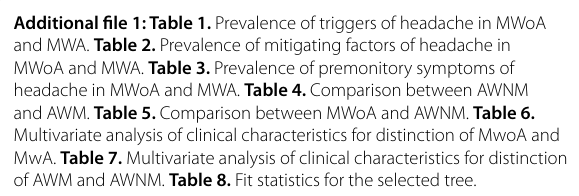
MwA. Table 7. Multivariate analysis of clinical characteristics for distinction of AWM and AWNM. Table 8. Fit statistics for the selected tree. Acknowledgements Not